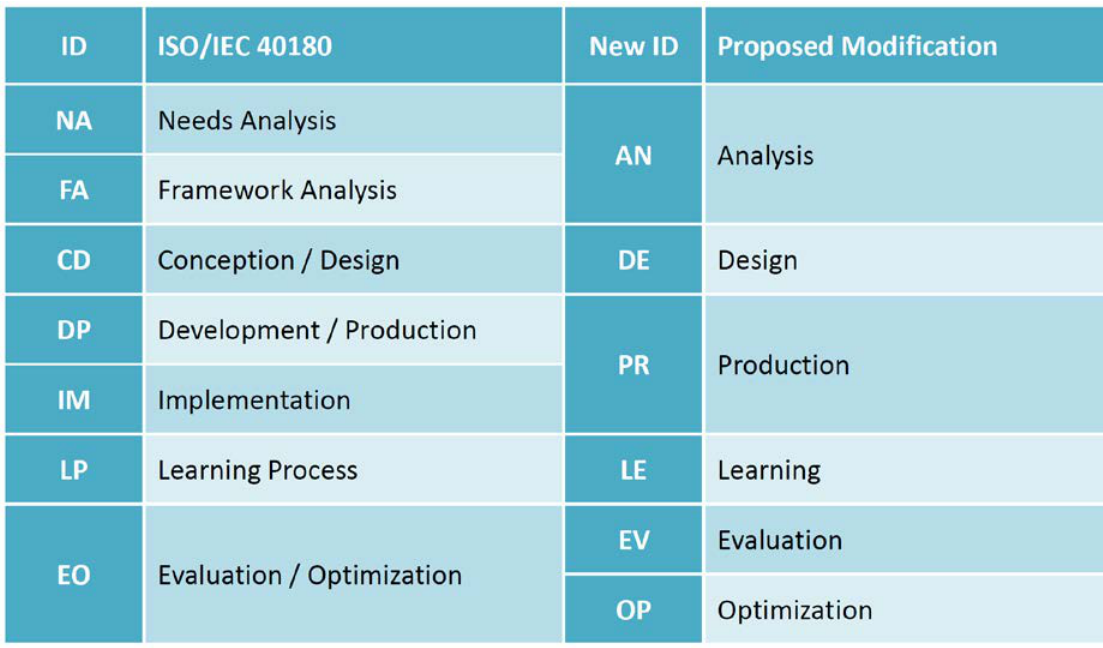
Process Categories of ISO/IEC 40180 and Proposed